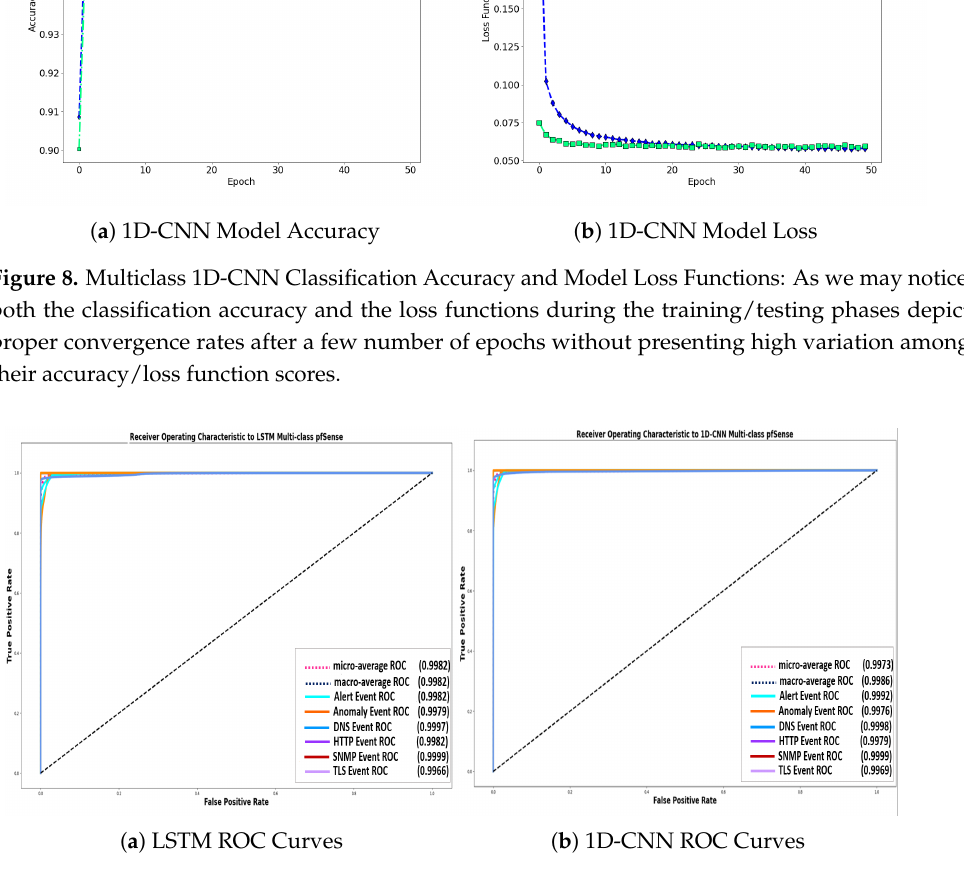
Figure 9. AUC-ROC Curve of the proposed Multiclass LSTM and 1D-CNN Architectures: In this figure we illustrate the AUC-ROC Curves for the 6-Eventy type category of the pfSense network logs. Comparing the proposed two schemes, we observe their high and robust performance towards the pfSense categories multi-class classification/anomaly detection